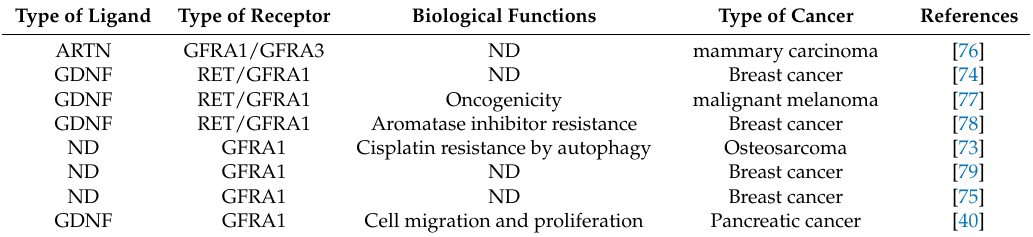
Table 1. The expression of GDNF ligands and its receptors in cancer